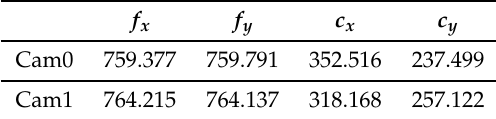
Figure 11. ( a ) Stereo camera system and C16 Leishen LiDAR Scanner. The two cameras provide ground truth parameters. ( b ) The environment of calibration. Table 2. Intrinsic parameters of stereo cameras.